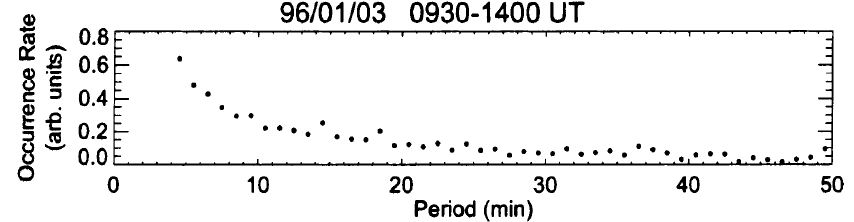
Fig. 5. The distribution of the velocity fluctuation periods from Fig. 4 for the 09:00–13:00 UT interval on 3 January, 1996, for velocity fluctuations with periods between 0 and 50 min. The distribution has a high occurrence rate at low periods that decreases with increasing period, and is typical of the PIF